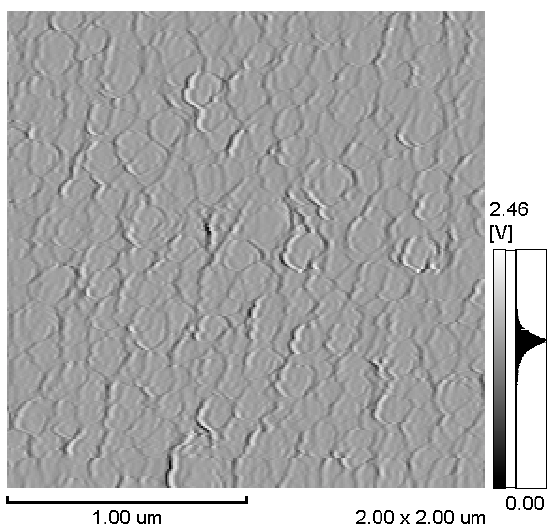
Figure 4. Atomic force microscopy image of the deposited film.